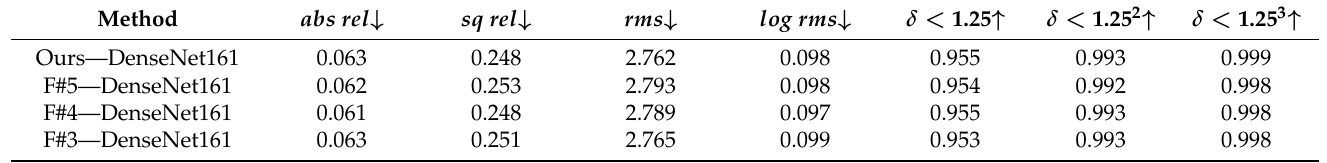
Table 6. The quantitative results of the pyramid structures with different floor numbers on the KITTI dataset. F#5, F#4, F#3 indicate the pyramids with 5 floors, 4 floors and 3 floors, respectively. Note that the floor number of ours—DenseNet161 is 6. Metrics indicated by ↓ : lower is better; metrics indicated by ↑ : higher is